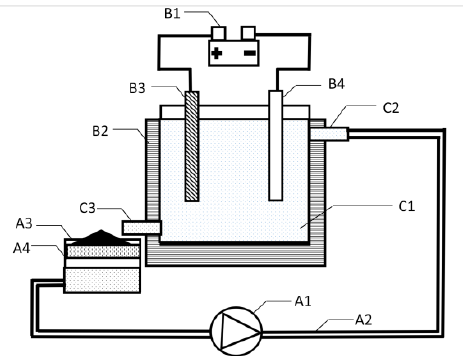
Figure 1. The design and assembly of the circulation flow-electric field device (A1: Flow Pump; A2: Connection Pipe; A3: Sponge Cadmium; A4: Electrolyte Reservoir; B1:Constant CurrentPower; B2: Thermostat; B3: Anode; B4: Cathode; C1: Electrolytic Cell; C2: Inlet; C3: Outlet).